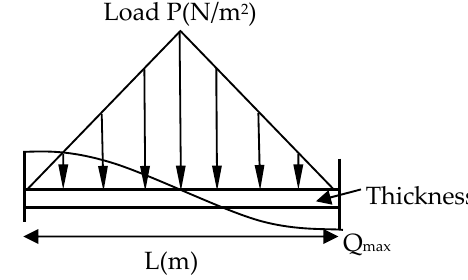
Figure 13. Reple shear failure.